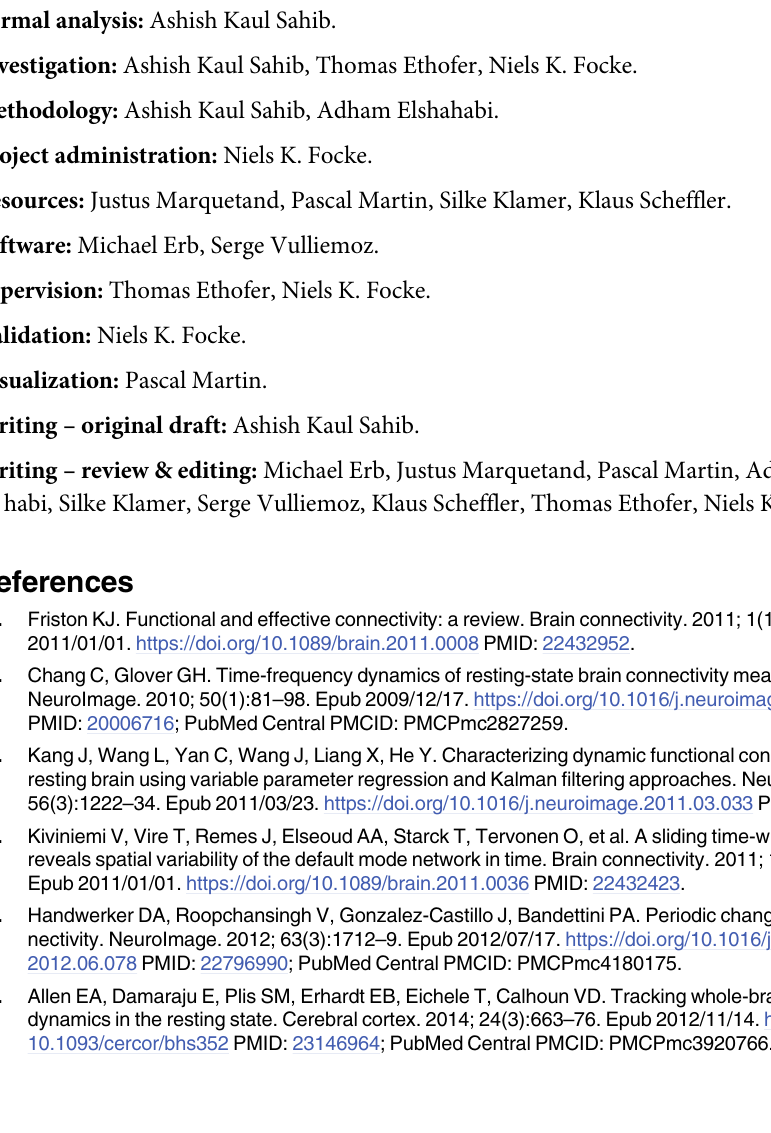
S3 Fig. FCD maps at time point zero (onset of IED). FCD values overlaid on the subject spe- cific T1 normalized image. (TIF) S4 Fig. Mean BOLD signal across atlas based regions in epileptic patients. Mean BOLD sig- nal across time (-20 to 30 s) for cortical regions as defined by the Freesurfer atlas. The 0 s indi- cates the IED onset. (TIF) S1 Table. Paired t-test across windows and TRs (p < 0.05, Bonferroni corrected) for peak 1 and peak